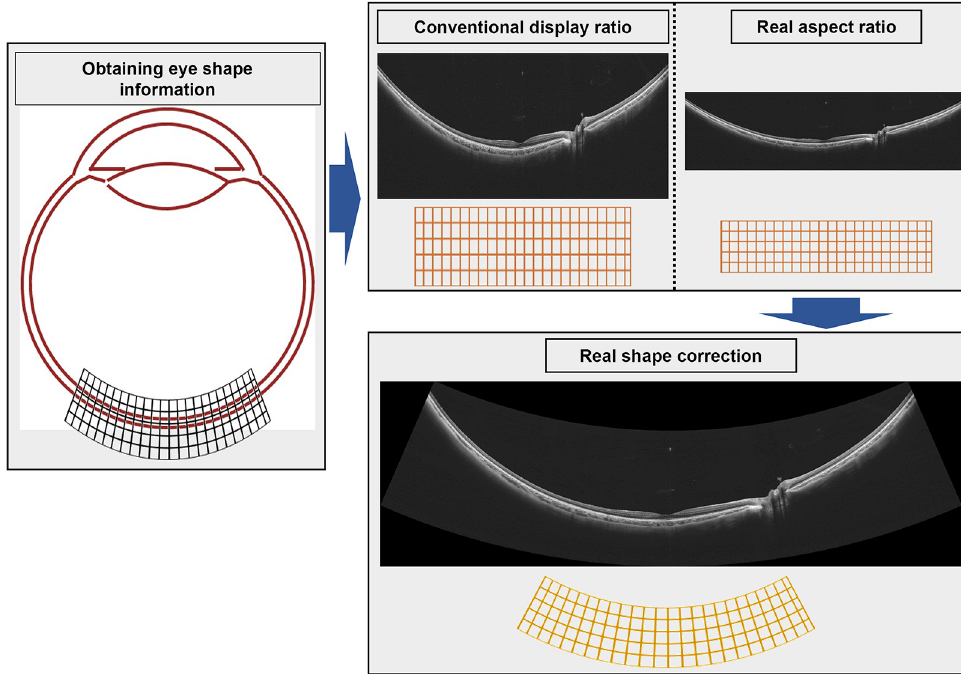
Fig 2. Real-shape correction of OCT images. We acquired information on eye shape when taking ultra-widefield OCT images. Conventional OCT images are displayed stretched vertically, but this method displays them in a 1:1 actual size ratio. Choroidal thickness was analyzed after real-shape correction of the OCT image, to correspond to the eye shape information acquired when the image was taken. Abbreviations: OCT, optical coherence tomography.